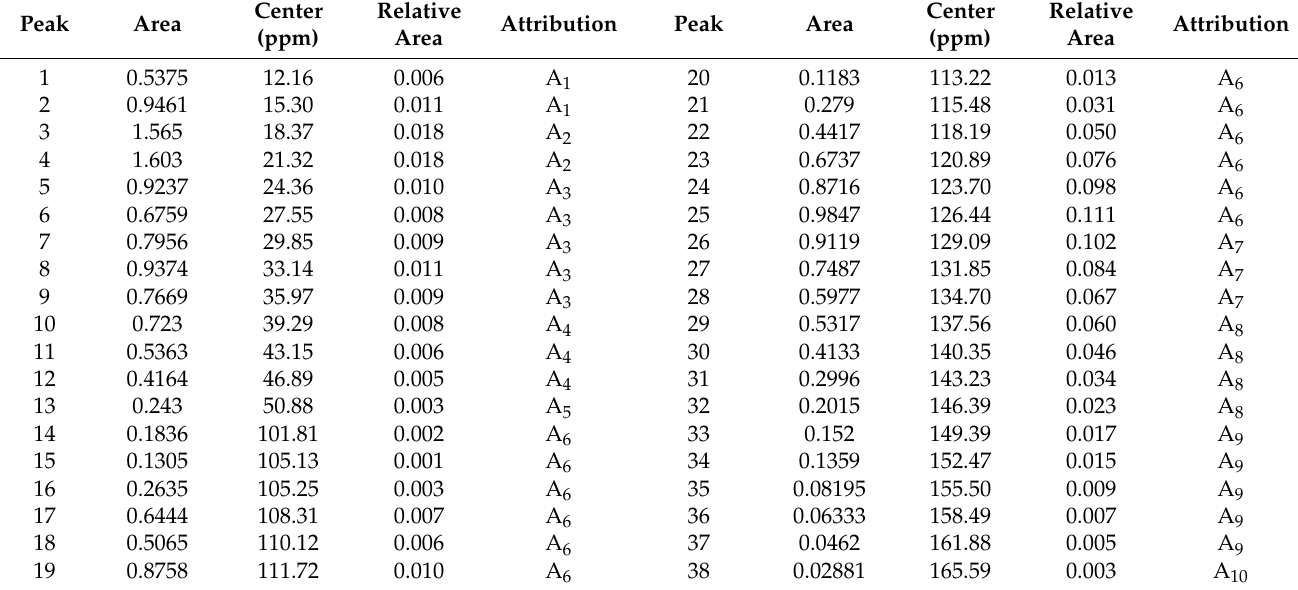
Table 3. Carbon structure attribution and proportion.